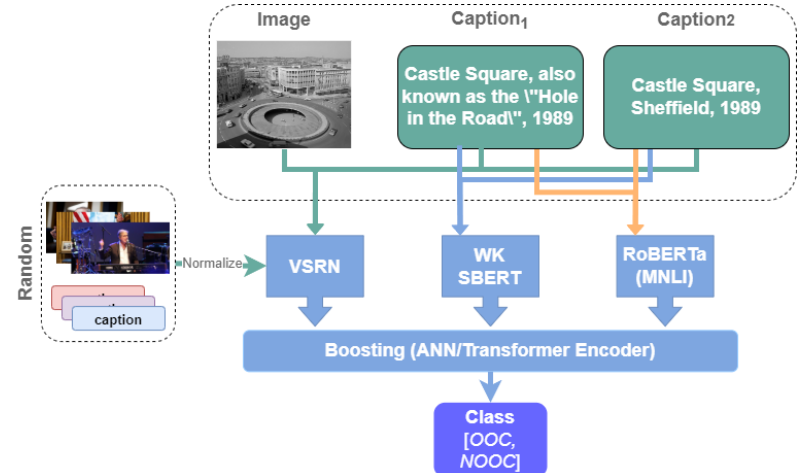
Figure 6. Illustration of boosting with image–caption matching method. First, image, caption 1 , and caption 2 will be inferred through VSRN [39] and normalized by Equation (4) to obtain matching scores (ˆS ( I , C 1 ) , ˆS ( I , C 2 ) ). In addition to enriching semantic correlation information between caption